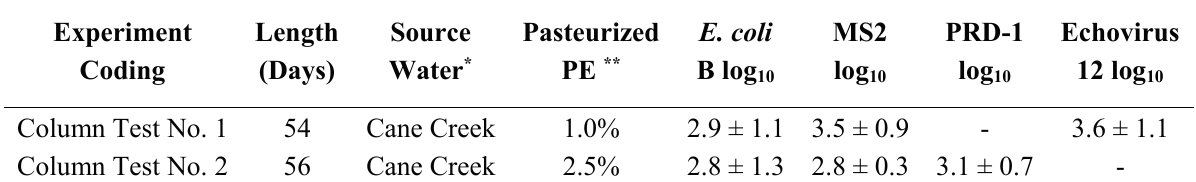
Table 2. Characteristics of feed water and study length for Column Tests No. 1 and 2. Microbial concentrations are mean log 10 measured concentration per mL and maximum log 10 deviation from the